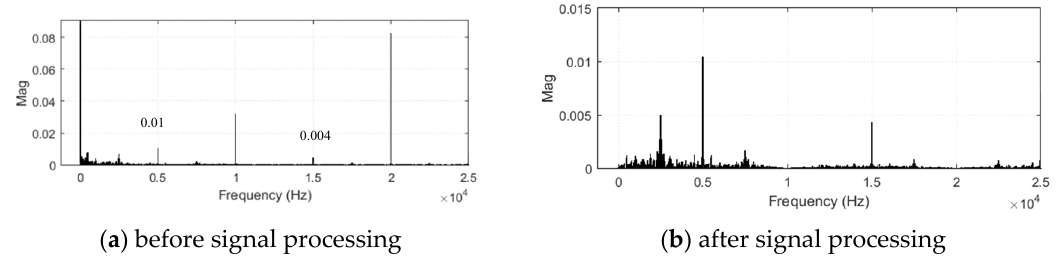
i before and after signal processing.